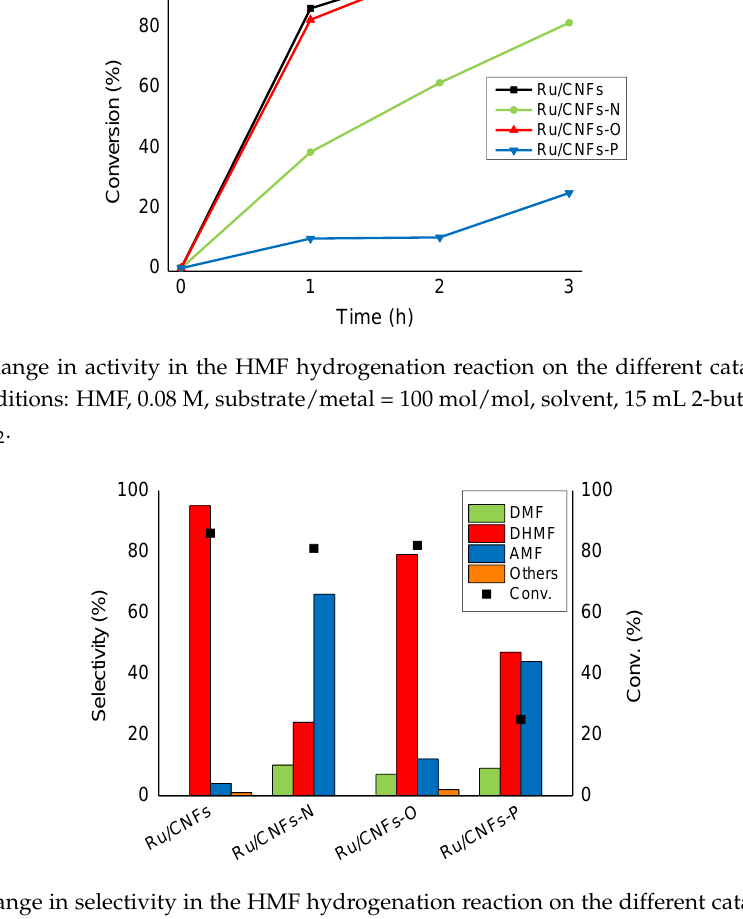
Figure 4. Change in activity in the HMF hydrogenation reaction on the different catalysts tested. Reaction conditions: HMF, 0.08 M, substrate/metal = 100 mol/mol, solvent, 15 mL 2-butanol, 150 °C, and 20 bar H 2 .